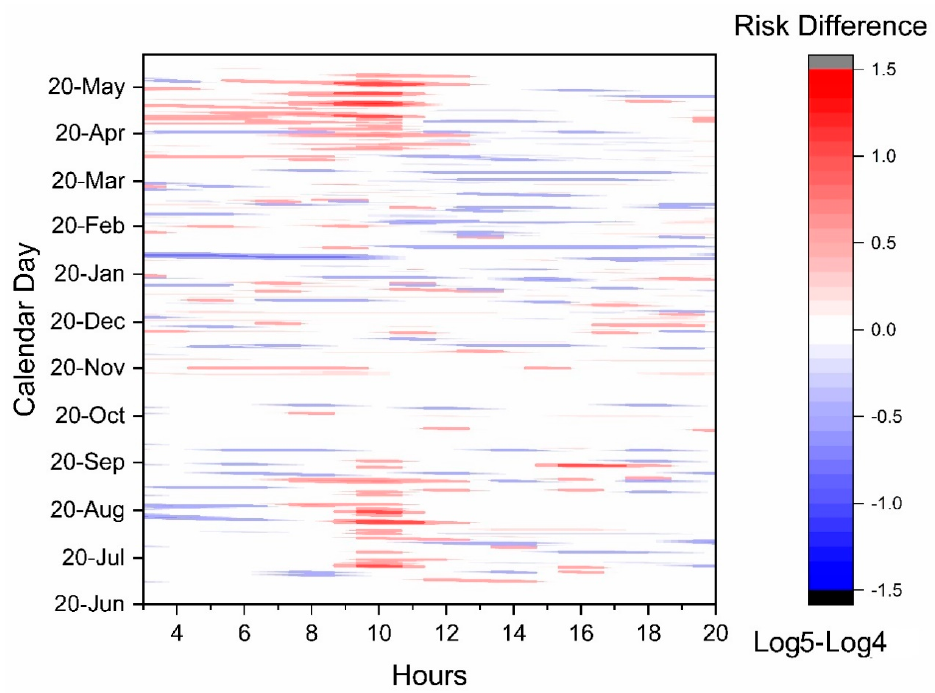
Figure 11. Risk difference caused by radiation disturbance as detected by the difference between Log5 and Log4. Red color, environmental conditions which trigger higher total risk; blue color, environmental conditions which trigger lower total risk.